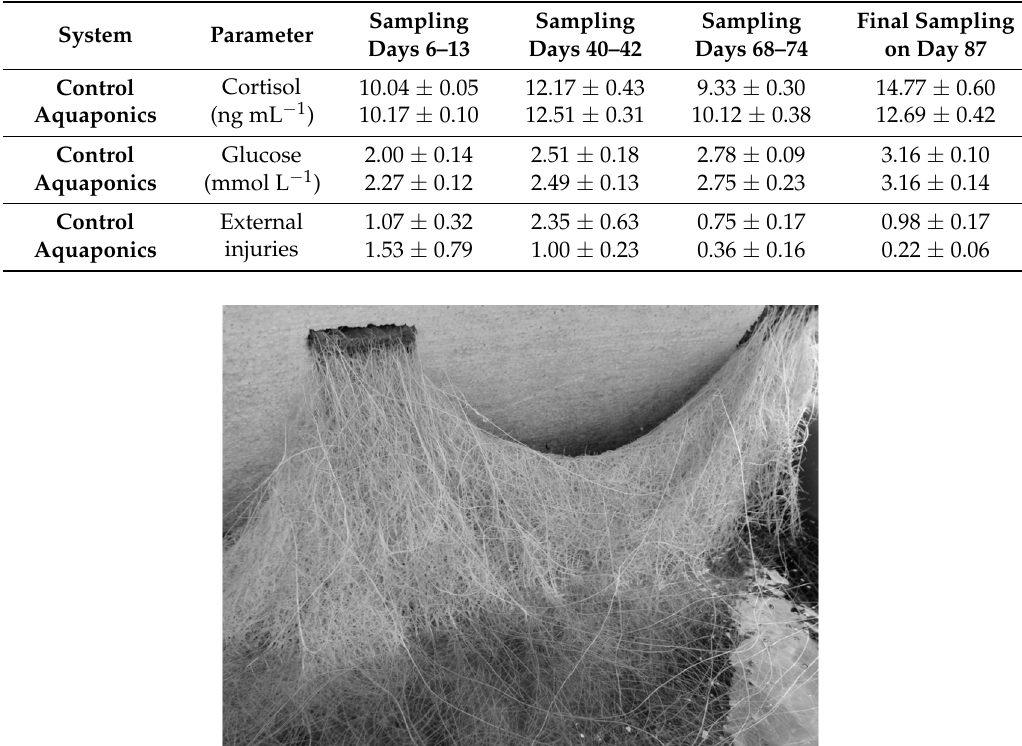
Table A1. The average ( ± SEM) temporal changes for the different stress and welfare parameters, in different phases of the experiment (Days 6–13, Days 40–42, Days 68–74 and the final sampling on Day 87).